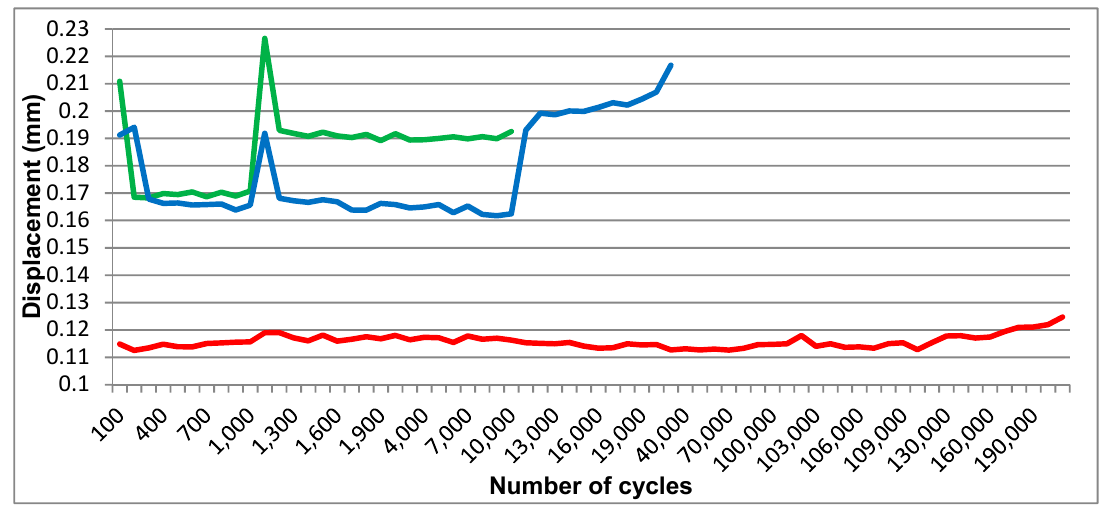
Figure 11. Dynamic testing for S1 (red), P2 (green), and P3 (blue). The peaks present in the green and blue line symoblize the removal and then aplication of the test device load cell in order to perform the Periotest measurements.